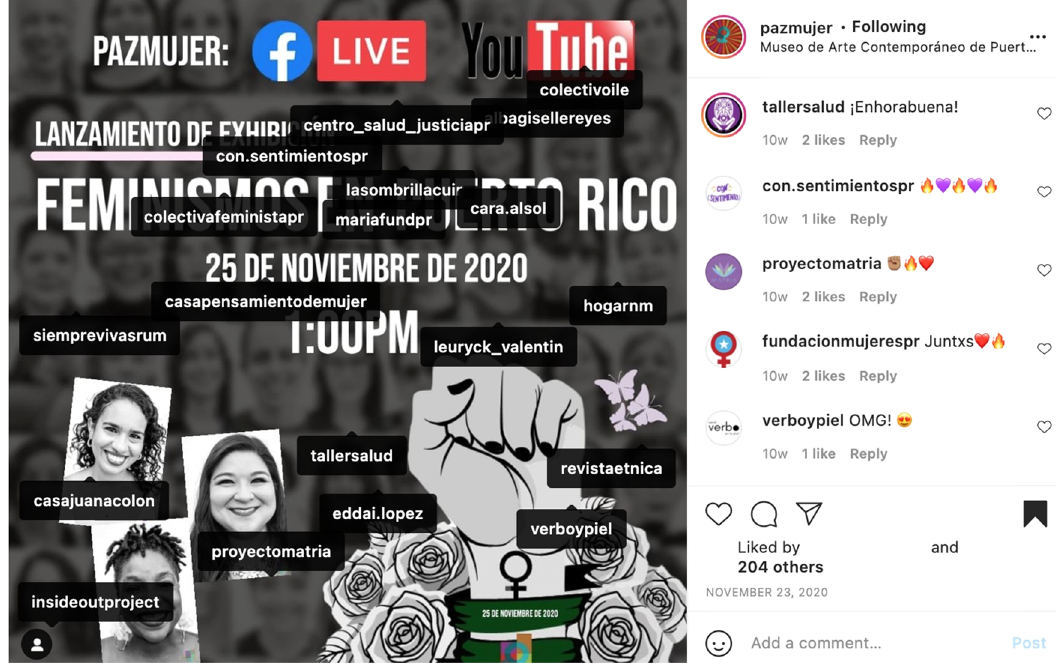
Figure 9: Screenshot from Coordinadora Paz para las Mujeres Instagram